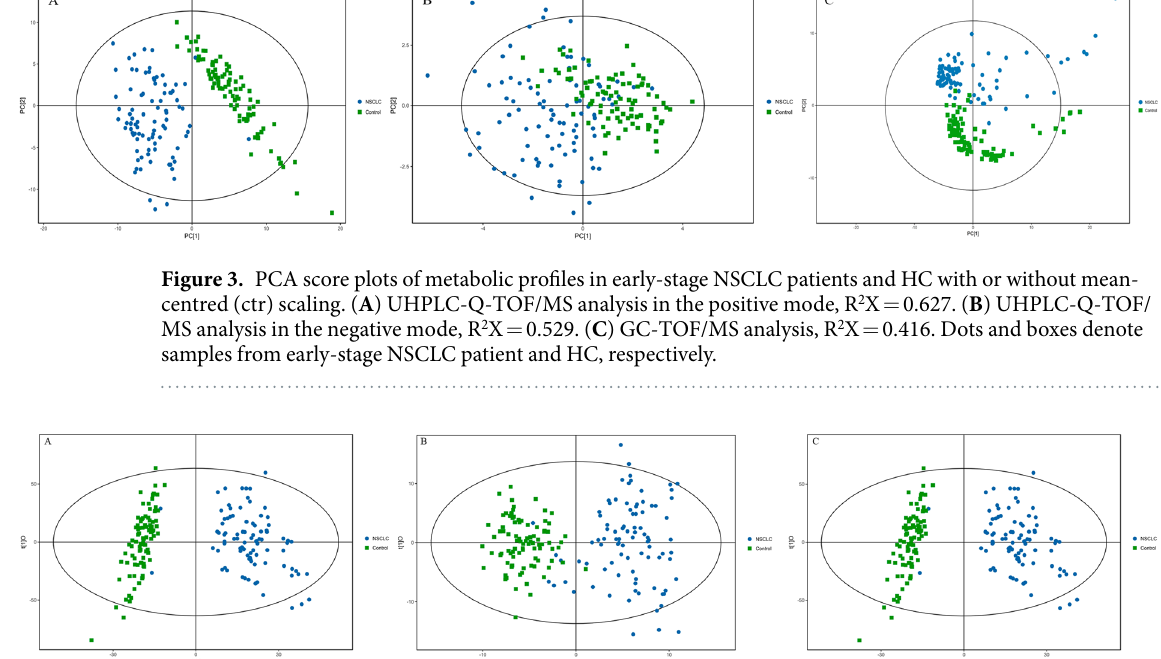
Figure 4. OPLS-DA score plot of metabolic profiles of early-stage NSCLC patients and HC after unit variance (uv) scaling. ( A ) UHPLC-Q-TOF/MS analysis in the positive mode. ( B ) UHPLC-Q-TOF/MS analysis in the negative mode. ( C ) GC-TOF/MS analysis.